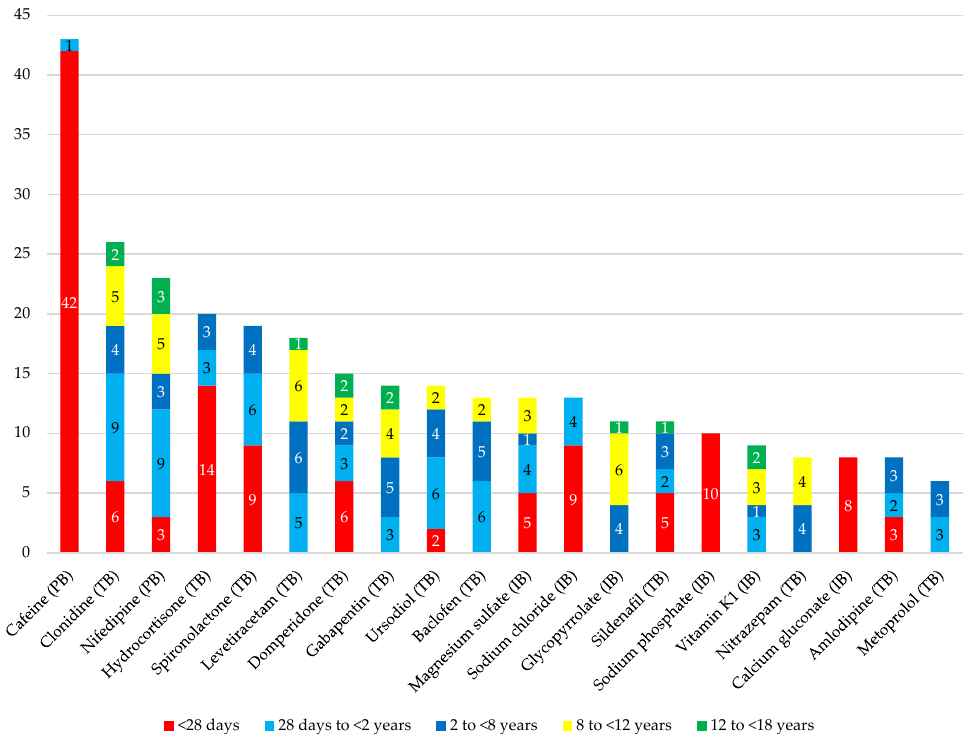
Figure 1. Flow chart of prescription type identification results. Abbreviations: API, active pharma-ceutical ingredient; CDEA, compounded drug for enteral administration; ODT, orodispersible tablet; OS, other solid; TS, tablet splitting.